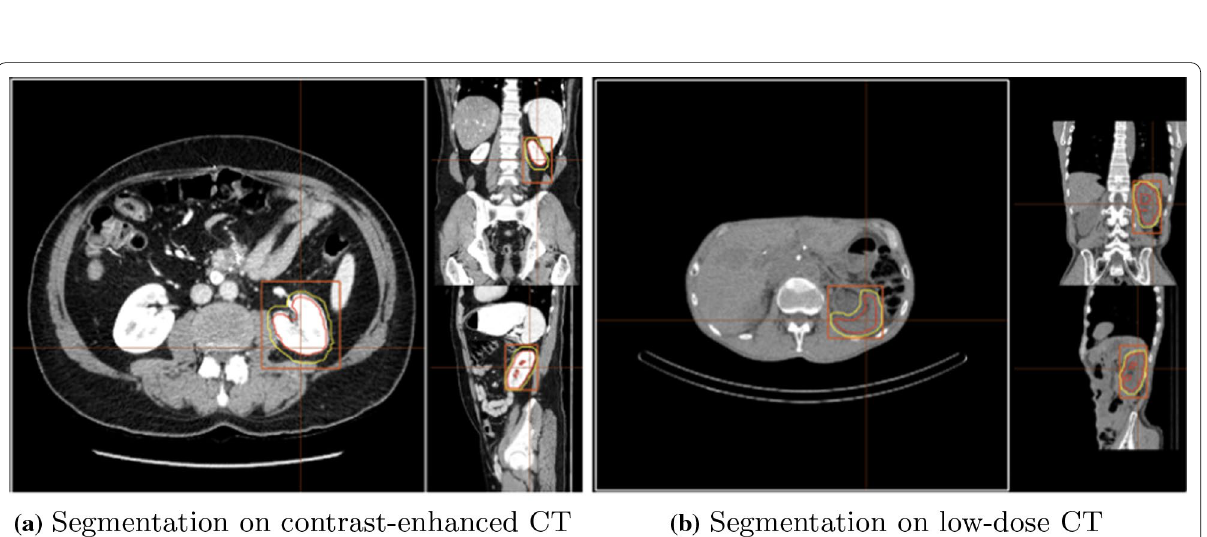
Fig. 2 Segmented left kidney along axial, sagittal and coronal axis using the AI . The segmentation boundaries are highlighted with red contour on a contrast‑enhanced CT on the left‑hand side and on a low‑dose CT on the right‑hand side. The red rectangle corresponds to the bounding box used in kidney detection by the algorithm and the yellow contour is the 3 mm expanded region for activity retrieval from the SPECT images based on the